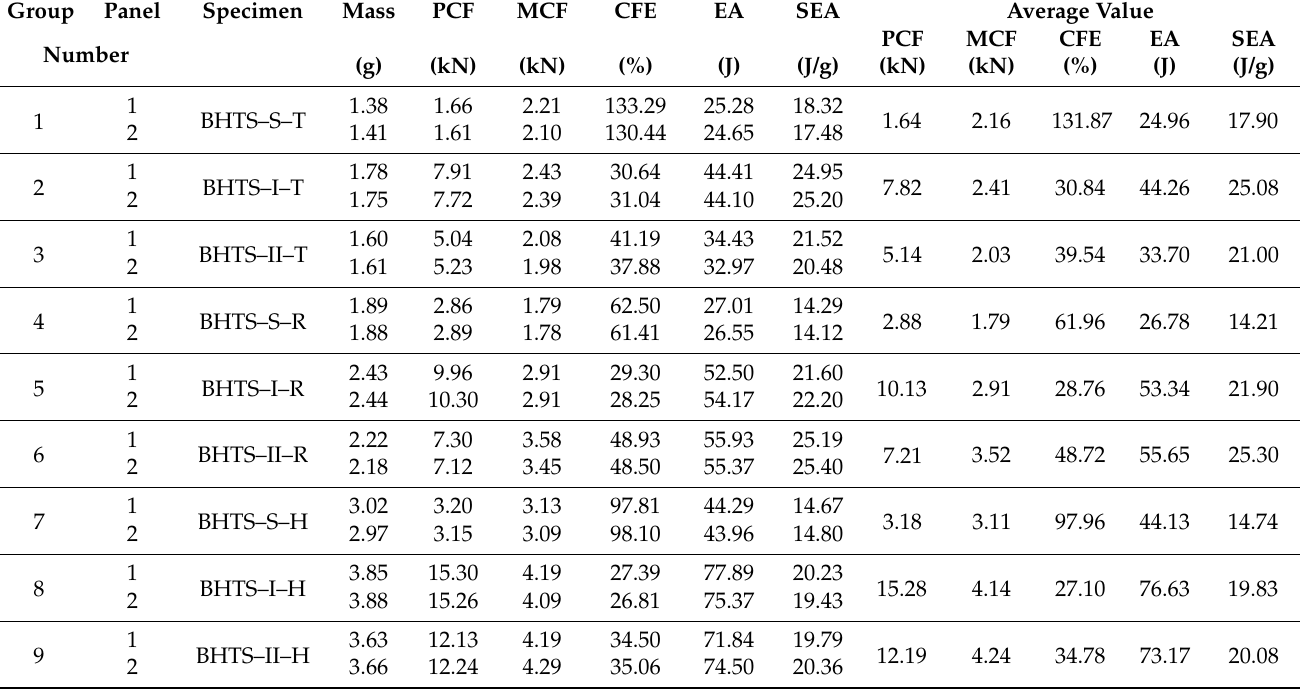
Table 4. Evaluation index values of mechanical properties of BHTS under different strain